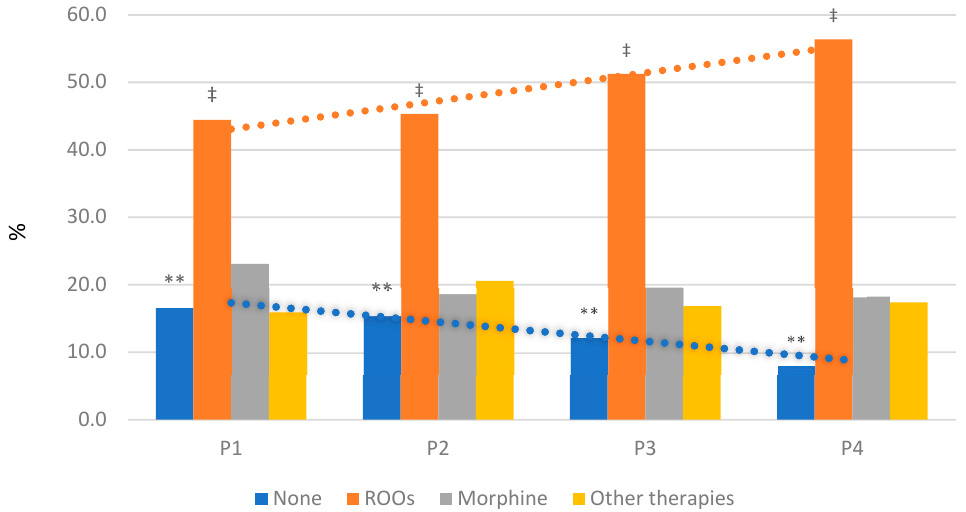
Figure 5. Distribution of therapies according to phenotypes. The NP-BTcP management differs between phenotypes. Orange trend indicates significant increase of ROOs from P1 to P4 (‡ p = 0.008); blue trend shows significant decrease of none therapy from P1 to P4 (** p = 0.003). Abbreviations: NP-BTcP—non-predictable breakthrough cancer pain; ROOs—rapid-onset opioids.